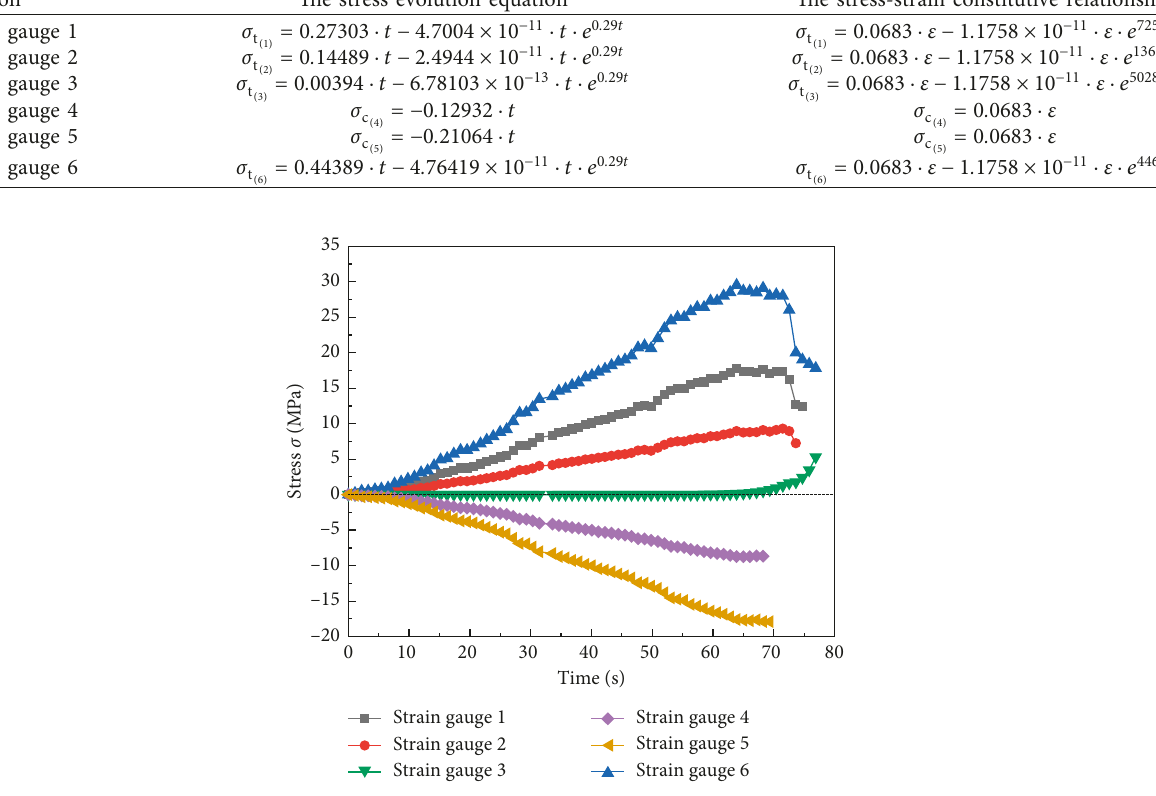
Figure 10: Relationship between the stress and time.